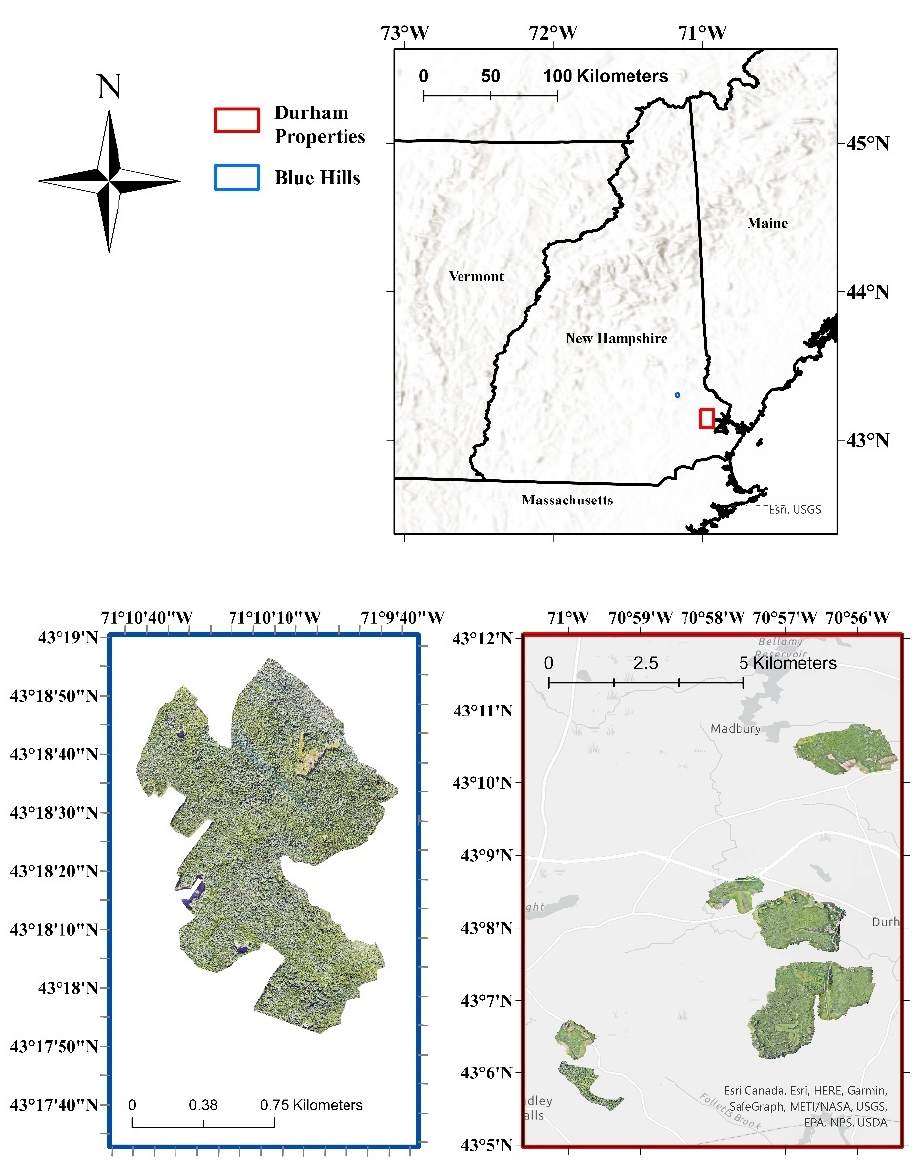
Figure 2. Location and unmanned aerial system (UAS) orthoimagery coverage of the nine study areas in southeastern New Hampshire (NH). In blue: the Blue Hills conservation lands in Strafford, NH. In red: the eight University of New Hampshire (UNH) study areas located near Durham, NH.